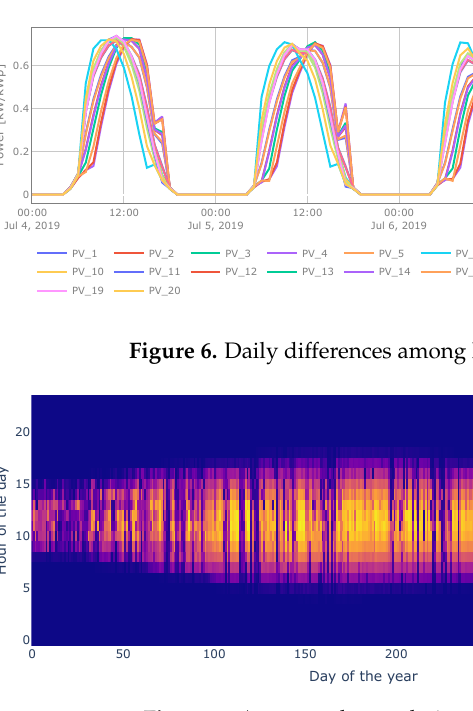
Figure 7. Average photovoltaic power